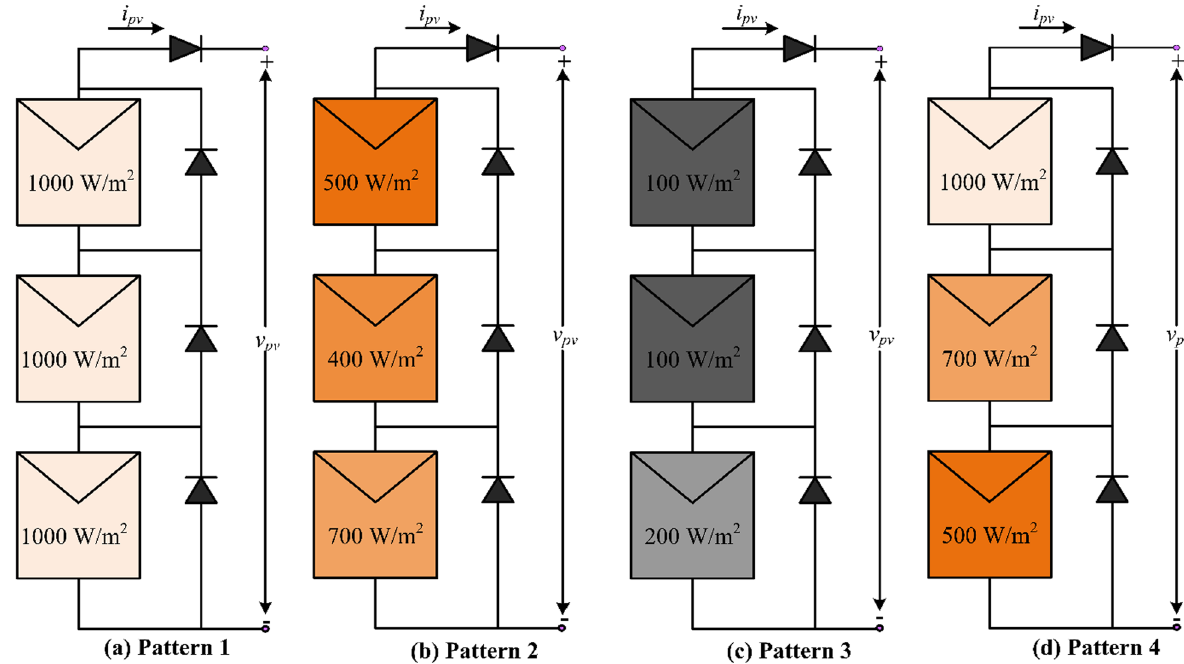
Fig. 20 PV module shading patterns for the proposed